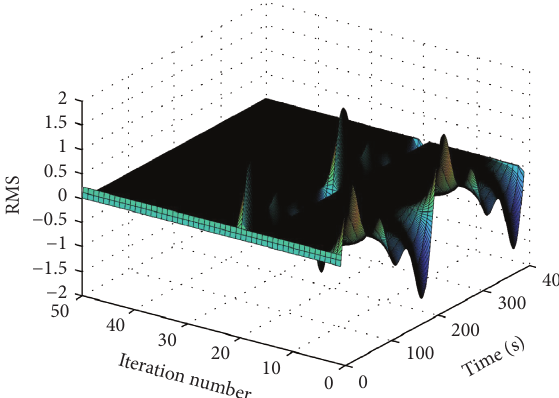
Figure 6: Error trajectory in both time and iteration domain (without actuator failure).